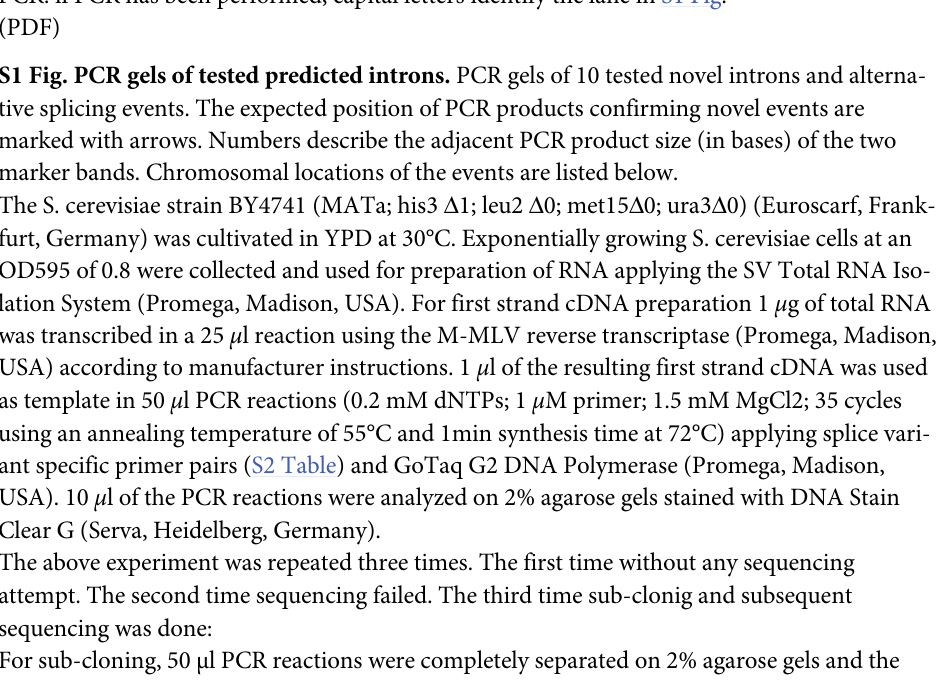
S1 Table. Predicted Introns. List of all predicted novel introns, sorted by evidence (read